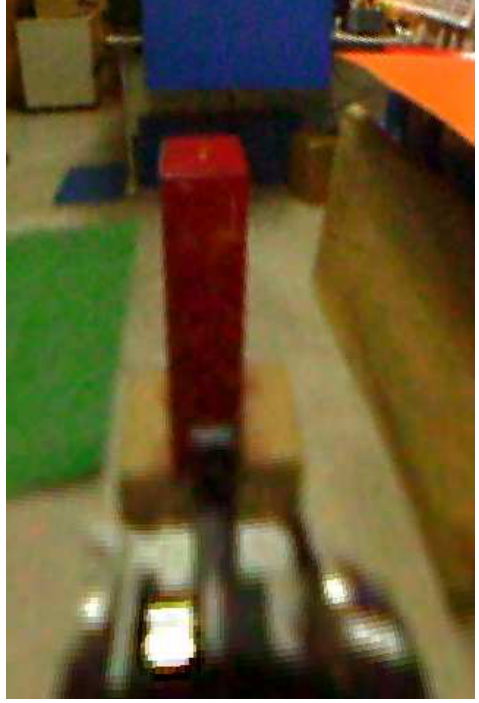
Figure 9. The virtual image generated from the omnidirectional image, Figure 8b. The image resolution is set as 320 × 480 for large overlap with the perspective image, Figure